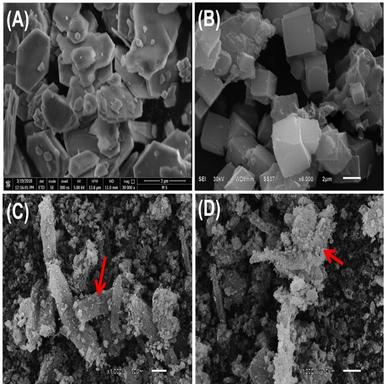
SEM images of kaolinite (A), synthetic zeolite-A (B), and the synthetic CF/ZA composite (C and D).